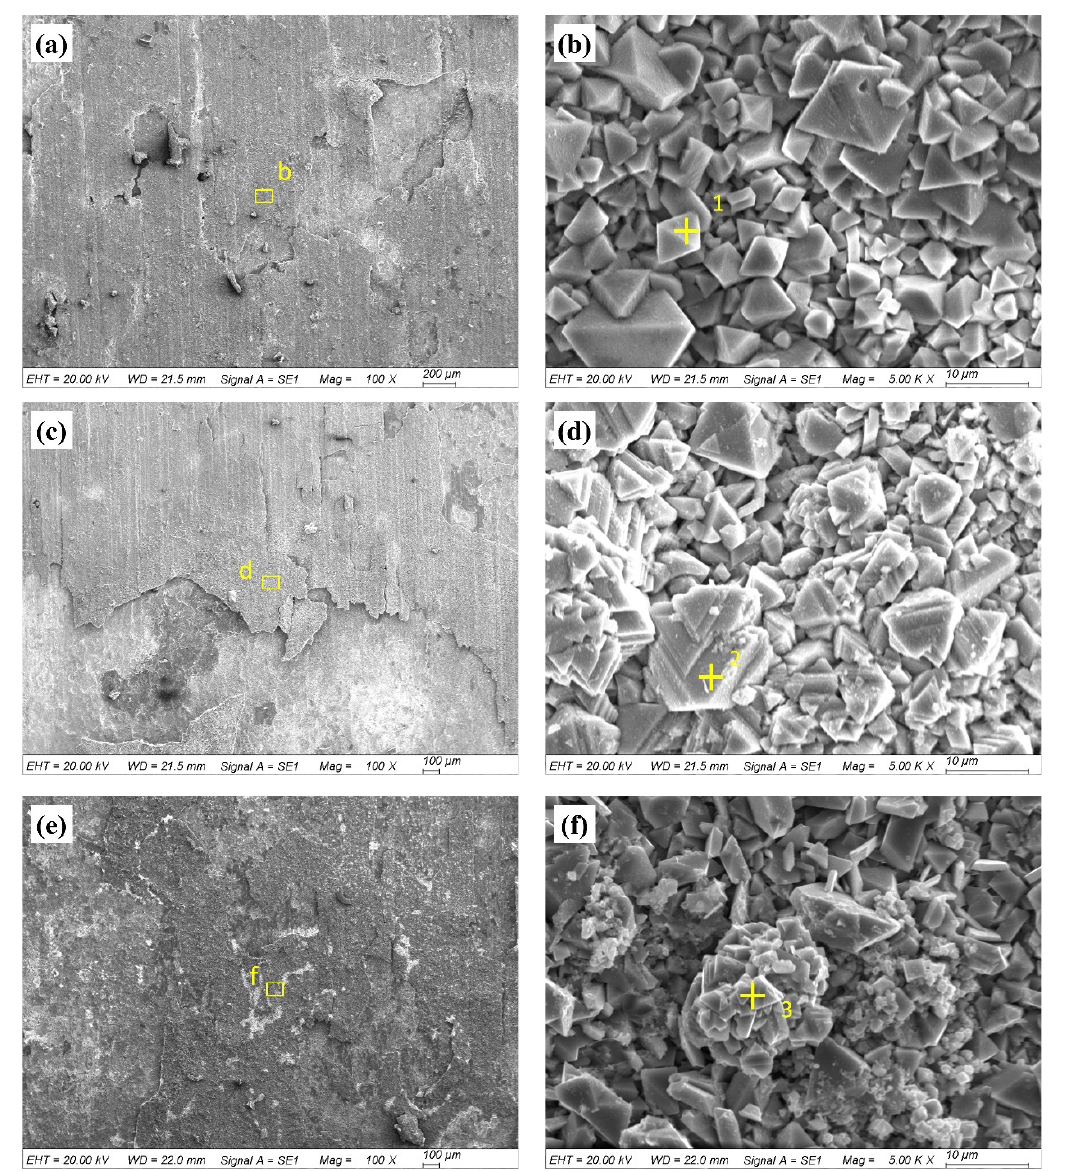
Figure 5. Surface morphologies of the repaired Inconel 718 specimen exposed to the molten salt at 650 °C for 50 h ( a ) at low magnification and ( b ) at high magnification, for 100 h ( c ) at low magnification and ( d ) at high magnification, and for 150 h ( e ) at low magnification and ( f ) at high magnification. Table 1. EDS analysis results of the areas indicated in Figure 5 (wt.%)